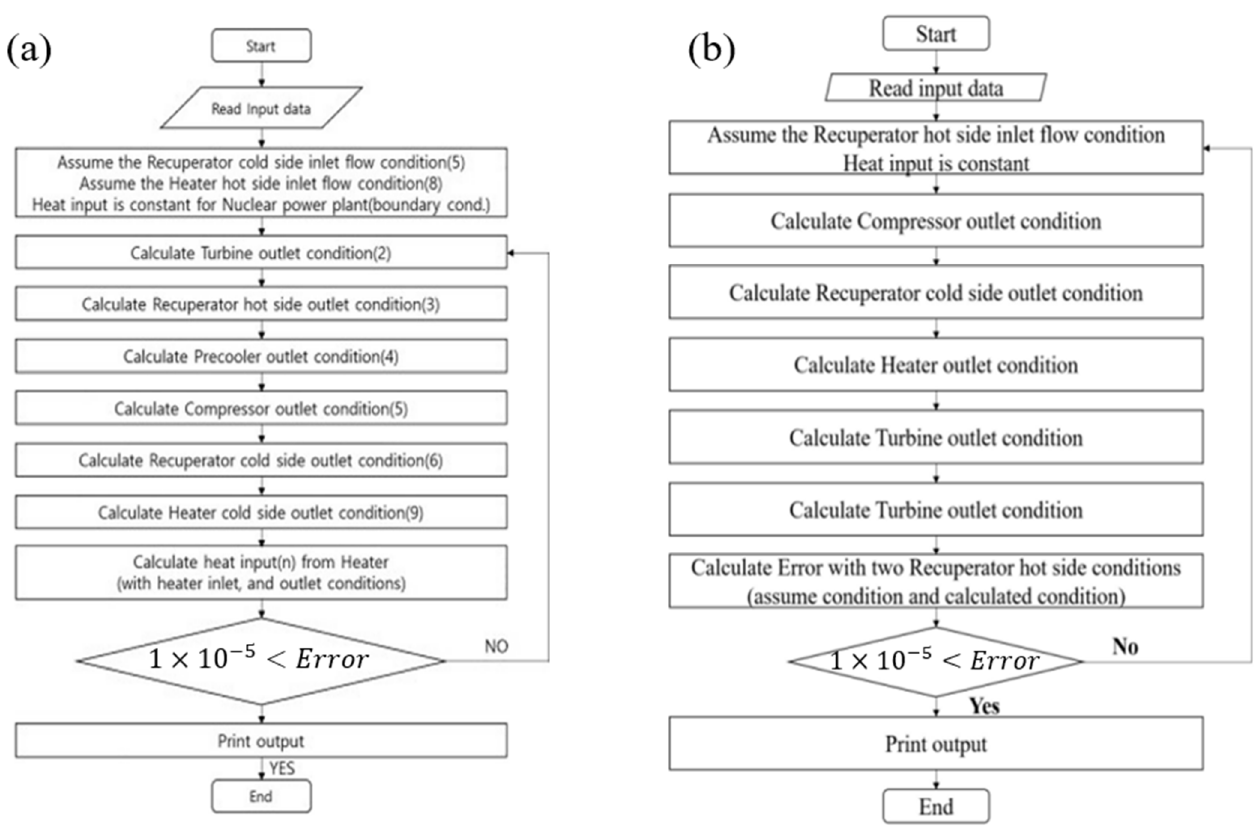
Figure 10. Flowchart for ( a ) KAIST-CCD and ( b ) KAIST-OCD.